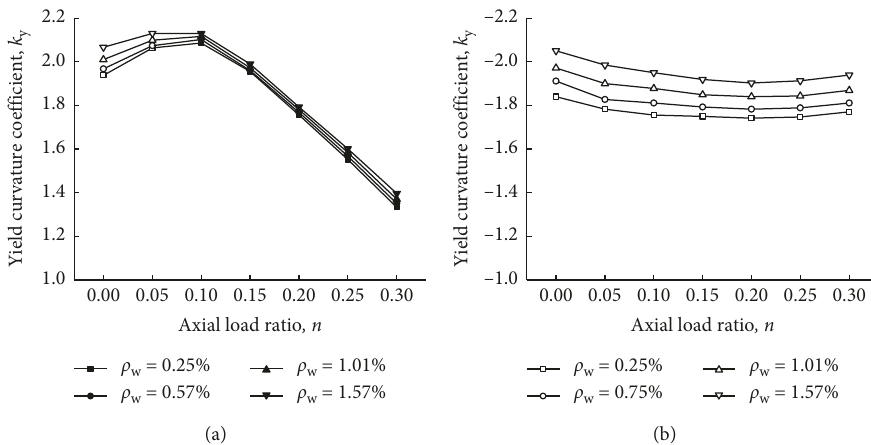
Figure 7: Variations in the yield curvature coefficient with the axial load ratio at different web distributed vertical reinforcement ratios. (a) Flange in tension. (b) Flange in compression.